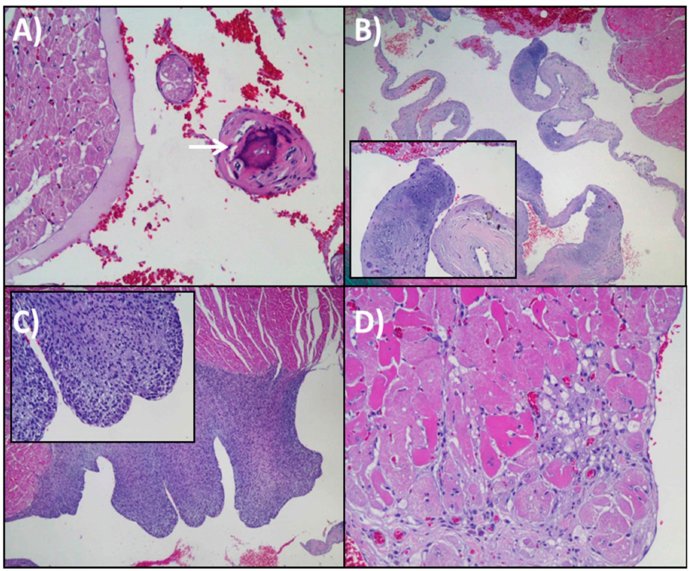
Figure 1. Representative images of histopathological features found in the heart of 24-months-old rats. ( A ) Papillary muscle calcification of left ventricle (white arrow). H & E 20 × . ( B ) Mucinous degeneration in the cardiac valves. H & E, 4 × . Insert 20 × . ( C ) Endomiocardic hyperplasia. The proliferation of spindle-shaped cells. H & E, 4 × . Insert, 20 × . ( D ) Vacuolar degeneration (fat) at intramyocardial level. H & E 20 ×